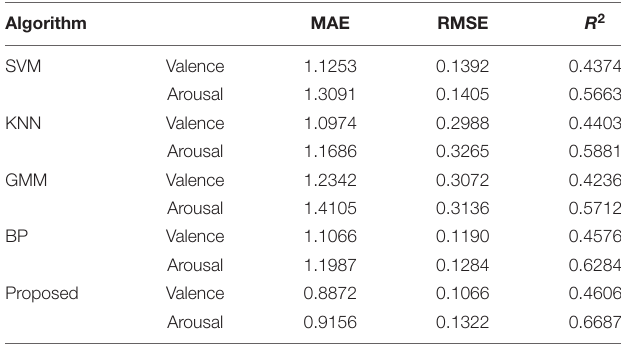
TABLE 3 | Experimental results of each recognition model.